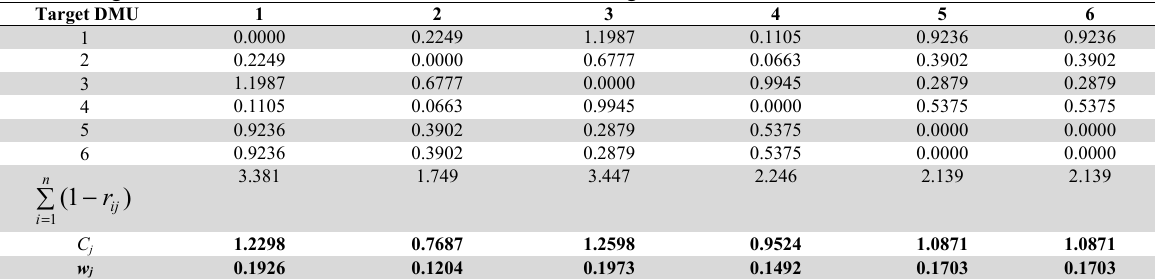
Criteria weights for the methods of rice weevil disinfestations using the CRITIC method Target DMU